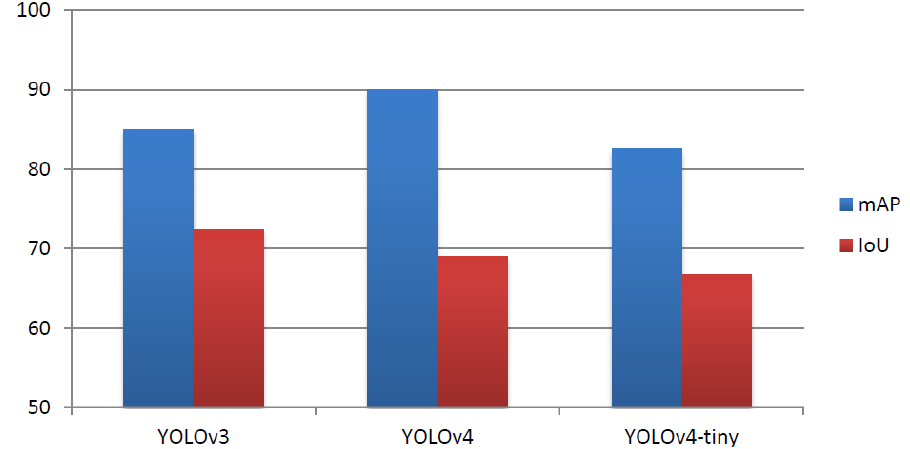
Figure 7. IoU and mAP indices for the three